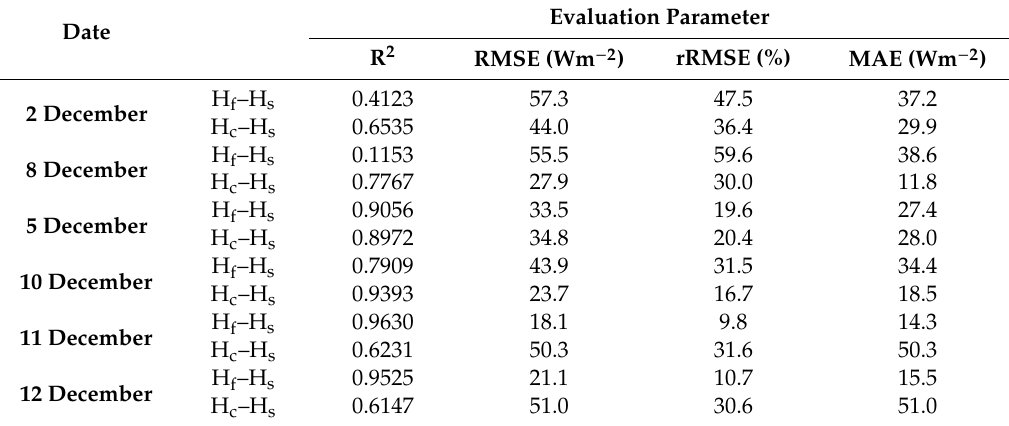
Table 3. Evaluation parameters of solar radiation estimation under di ff erent weather conditions.